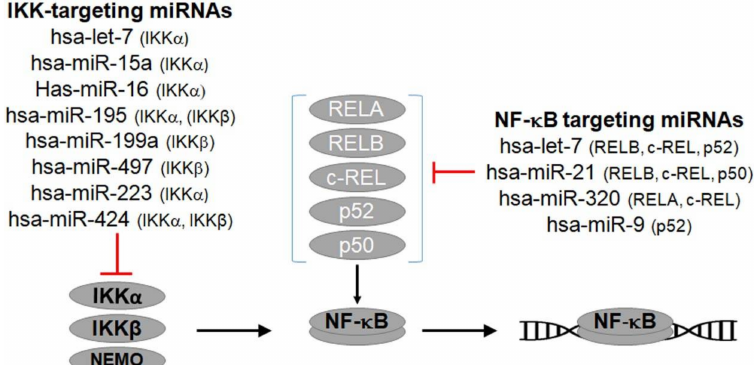
Figure 1. IKK and NF- κ B targeting miRNAs. MiRNAs targeting at least one of the NF- κ B signaling components such as one of the upstream NF- κ B activating kinases, IKK α or IKK β , or one of the NF- κ B transcription factor subunits. For a comprehensive list of NF- κ B targeting miRNAs, see Supplementary Table